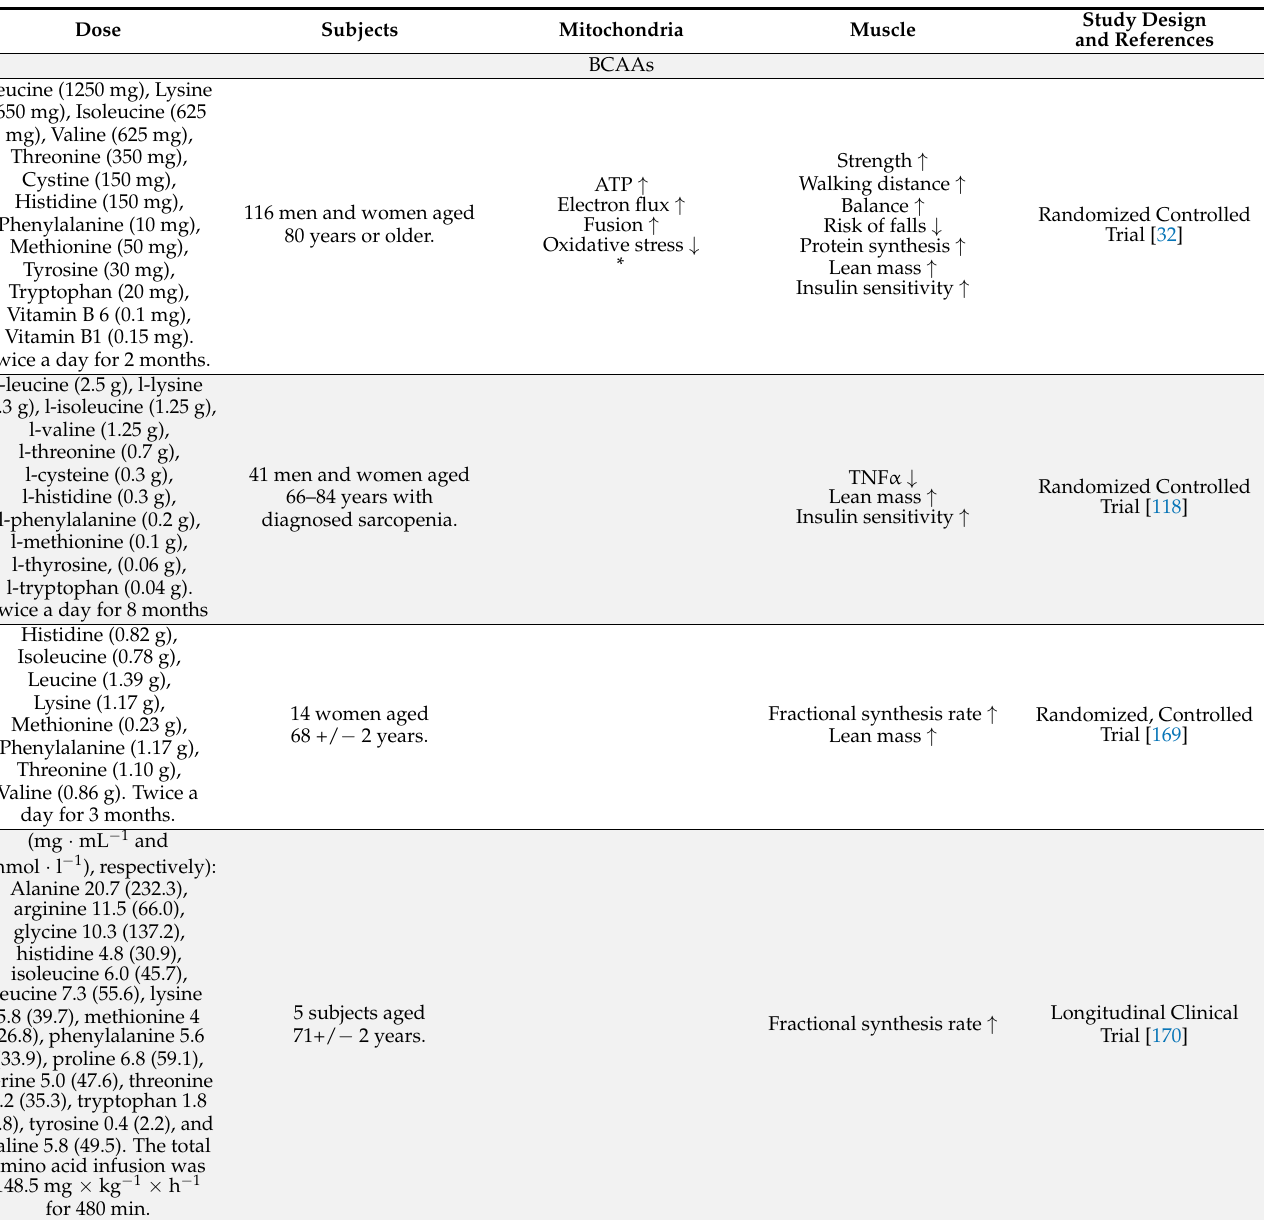
Table 2. Effects of dietary intervention on mitochondrial function, oxidative stress level, and clinical features of